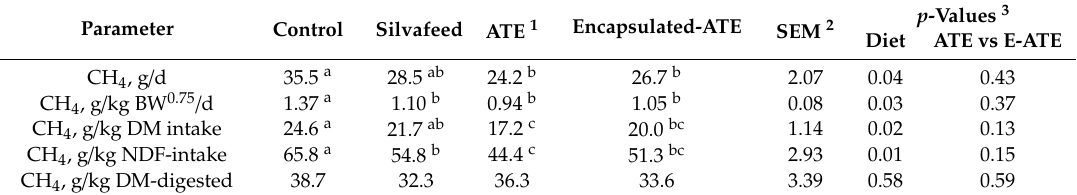
Table 5. Methane (CH 4 ) emissions in Merino wethers fed a total mixed ration containing crude extract or lipid-encapsulated Acacia